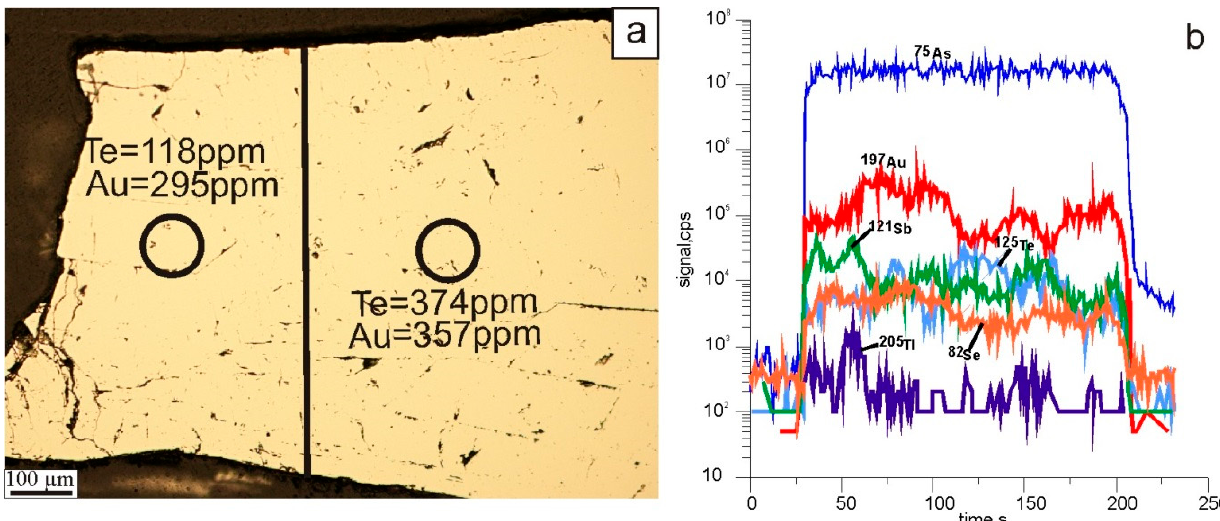
Figure 6. Arsenopyrite in skarnoid of the Vorontsovka deposit: ( a ) grain of Apy-1 from marble (skarnoid) with impregnation of arsenopyrite and sulphosalts in micro-veinlets, ( b ) LA-ICPMS profile; Co, Ni, Ag, Hg, Tl—not detected. Au is distributed zonally across the profile, as well as Sb and Te, but there is no correlation between the peaks of these element contents across the profile.